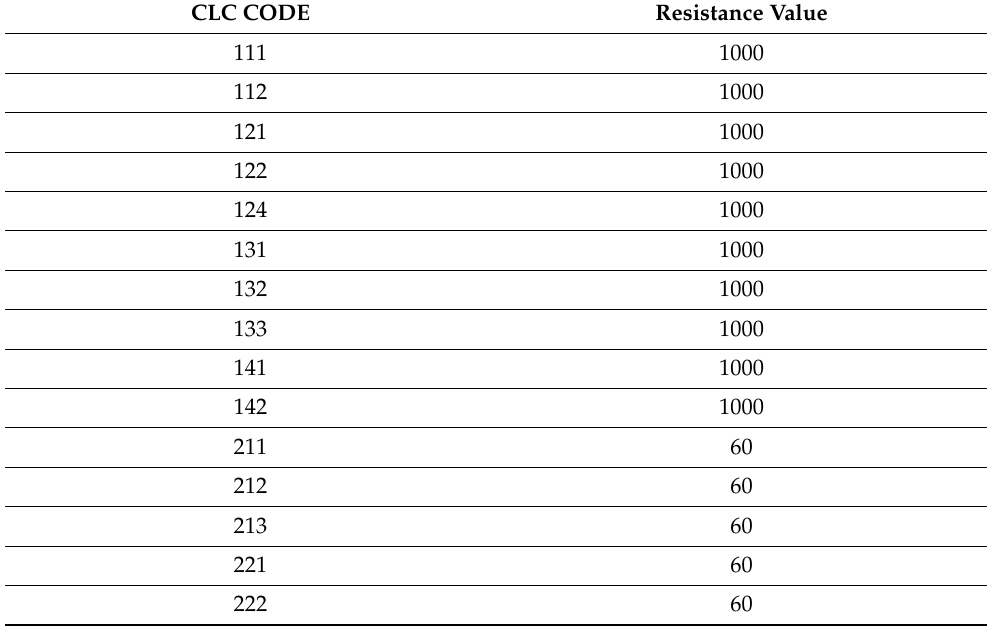
Table A1. Resistance values for Corine Land Cover 2018’s land use